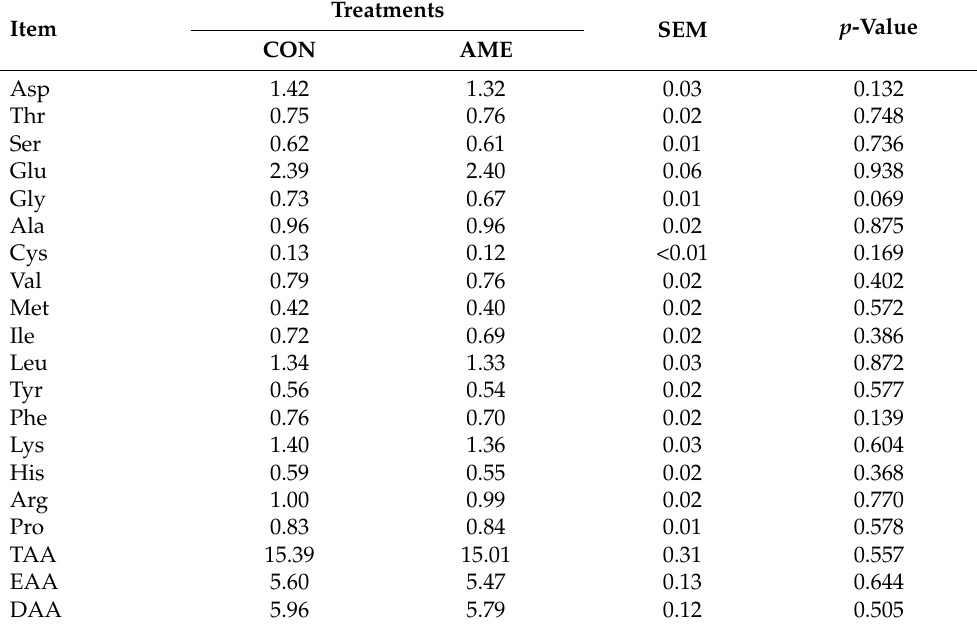
Table 4. Effect of AME on hydrolyzed protein amino acid composition in LD muscle of lambs (fresh sample basis g/100 g).